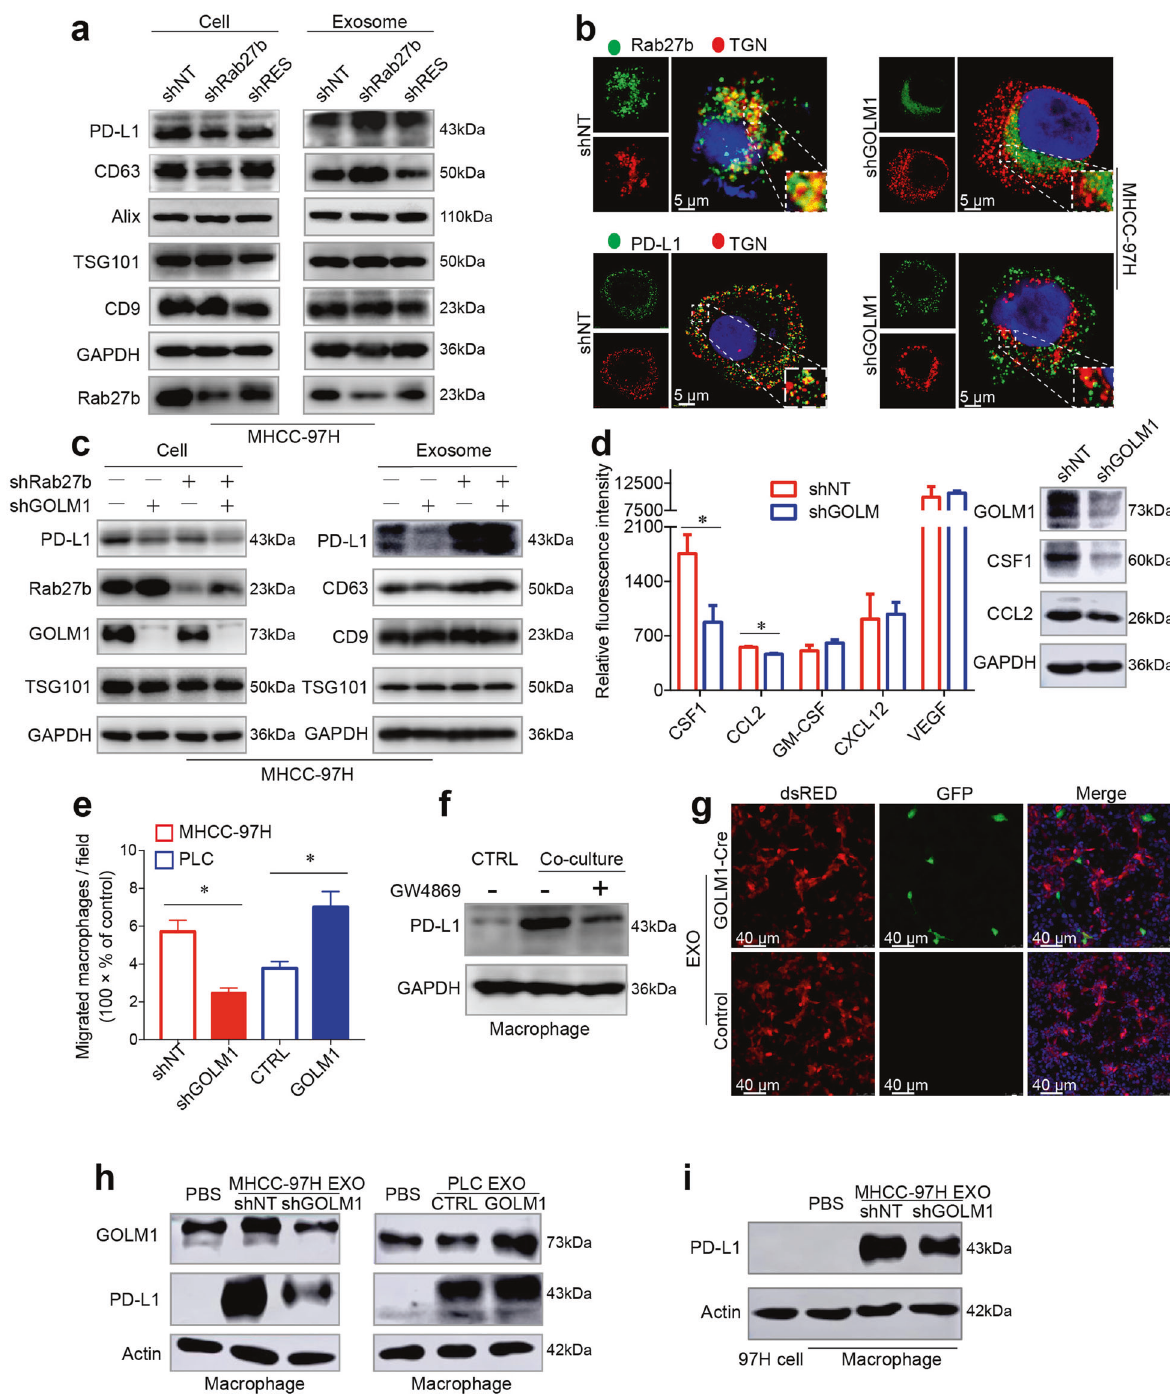
Fig. 5 GOLM1 facilitates PD-L1 sorting into exosomes and transport to macrophages via suppression of Rab27b. a Western blot analysis showed the alterations of PD-L1 expression on HCC cells and in exosomes from MHCC-97H cells after knockdown of Rab27b and reintroducing shRES- Rab27b into Rab27b-KD cells. b Immuno fl uorescence images demonstrated the co-localization of Rab27b (top panel) or PD-L1 (bottom panel) with TGN marker TGN46 in MHCC-97H-shNT and MHCC-97H-shGOLM1 cells. c Western blotting showed that the knockdown of Rab27b signi fi cantly increased the reduced PD-L1 expression in exosomes induced by GOLM1-KD in MHCC-97H cells. d Western blot validated the screening results of an antibody microarray containing a panel of 42 chemokines related to the chemotaxis of TAMs, in the supernatant of MHCC- 97H-shGOLM1 and MHCC-97H-shNT cells. e Migration assays revealed the association of macrophage migration with GOLM1 levels in HCC cells. f Western blotting analysis showed PD-L1 expression on macrophages after co-culture with MHCC-97H treated with exosome secretion inhibitor GW4869 (20 μ M) or DMSO (control) for 48 h. g Immuno fl uorescence images of THP1-derived macrophages. Exosomes isolated from MHCC-97H- GOLM1-Cre cells were added to cultures of macrophages expressing LoxP-DsRed-Stop-LoxP-eGFP. Macrophages switched from red to green indicated that GOLM1-Cre protein was successfully transferred by exosomes into macrophages. h Western blot showed the alterations in PD-L1 levels of macrophages co-cultured with exosomes derived from HCC cells with various GOLM1 expressions. i Western blot showed the PD-L1 levels of MHCC-97H cells and macrophages co-cultured with exosomes derived from MHCC-97H cells. * P <